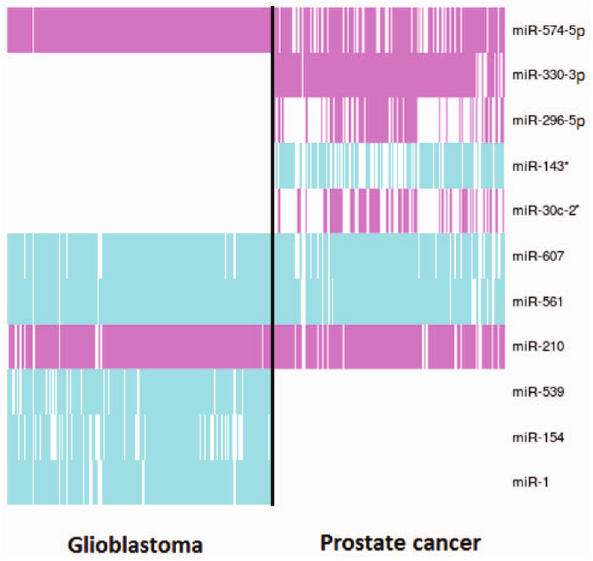
Figure 4. Predicted miRNAs in prostate cancer and glioblasto- ma patients. Pink is for over-expressed miRNAs and blue is for under- expressed. Each column represents a patient and each row a miRNA.